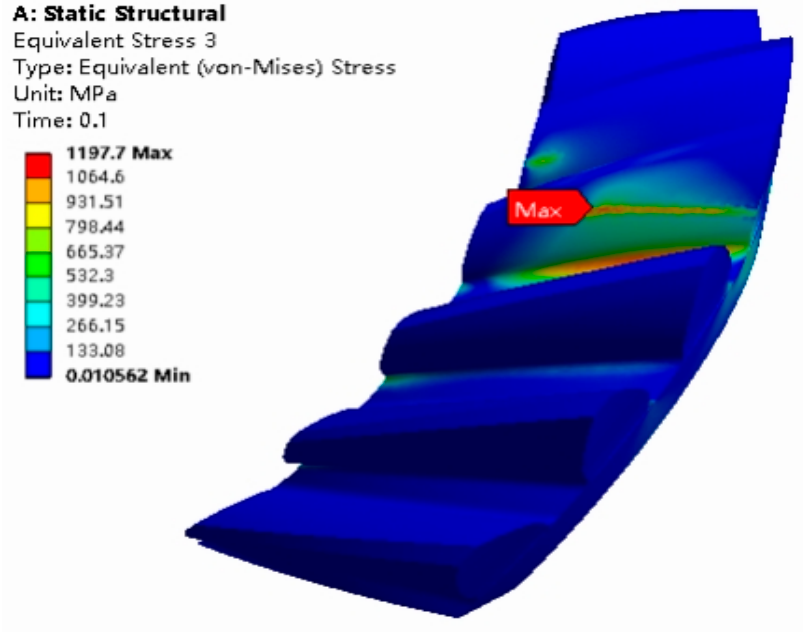
Figure 4. Stress distribution nephogram of the driving pinion.